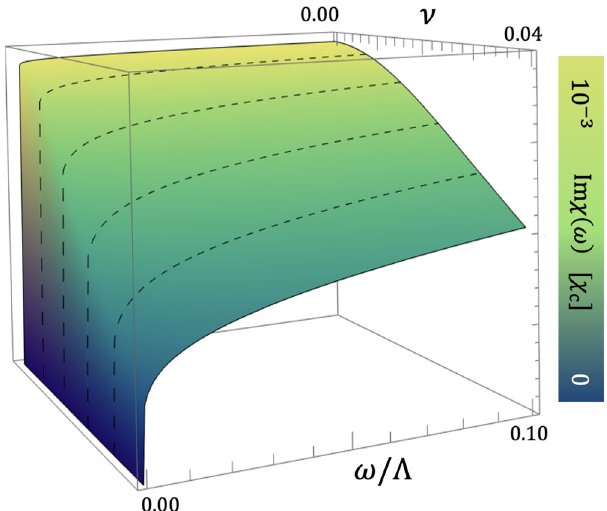
Fig. 3 Dynamical susceptibility away from criticality. Imaginary part of the dynamic pairing susceptibility χ ( ω ) for different values of the pair breaking, parametrized in terms of ν with γ = 0.01 and T / Λ = 10 − 4 . Notice the broad continuum right at the BKT quantum critical point that only decays like 1 = log 2 ω at lowest frequencies.